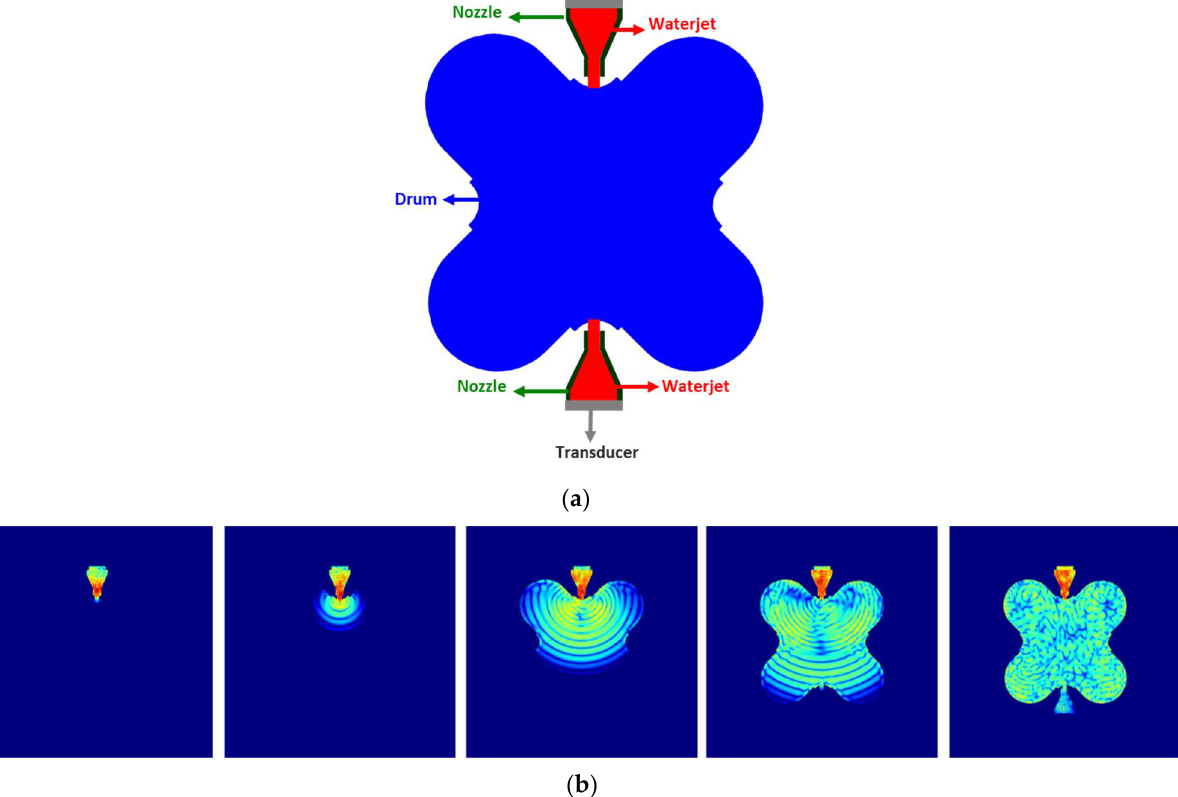
Figure 6. ( a ) Scenario and configurations for simulations; ( b ) snapshots of the wave propagation through the shaft cross section (from video Simulation Nozzle shaft in the Supplementary).